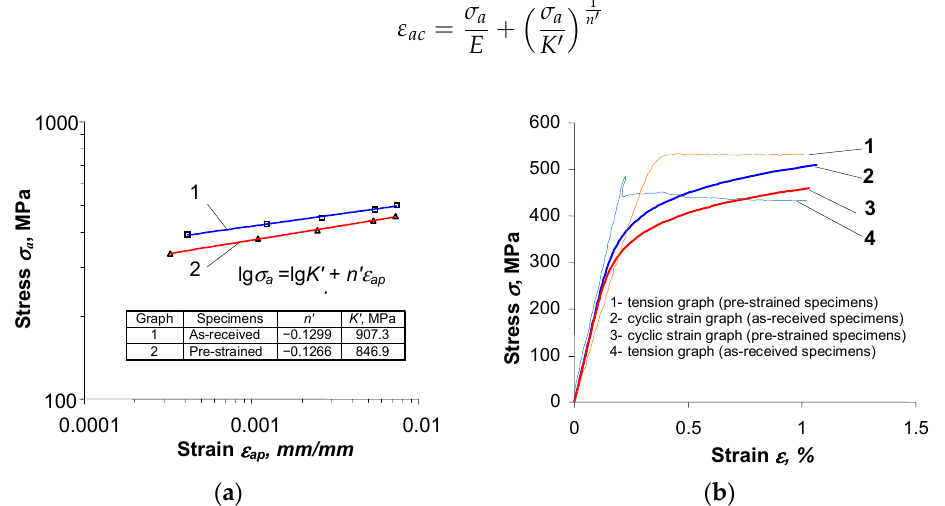
Figure 14. Results of tests on raw and pre-strained specimens: ( a ) relationship between stress σ a and strain ε ap , ( b ) tensile and cyclic strain